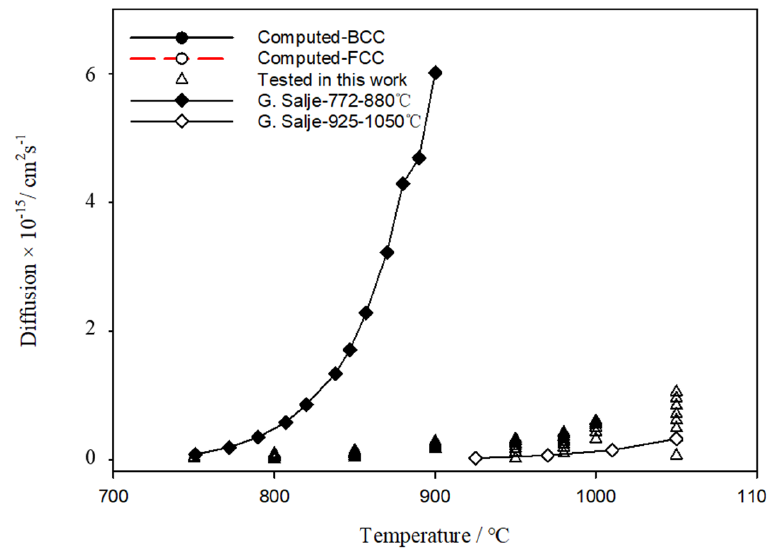
Figure 13. The comparison of diffusion coefficients at different temperatures.